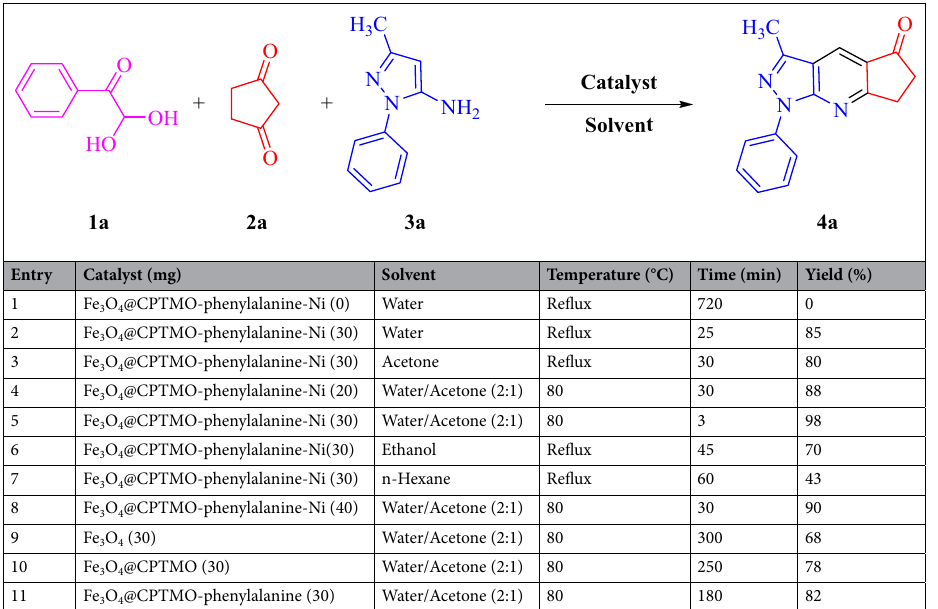
Table 2. Effect of some parameters (solvent and amount of catalyst) for the preparation of 4a